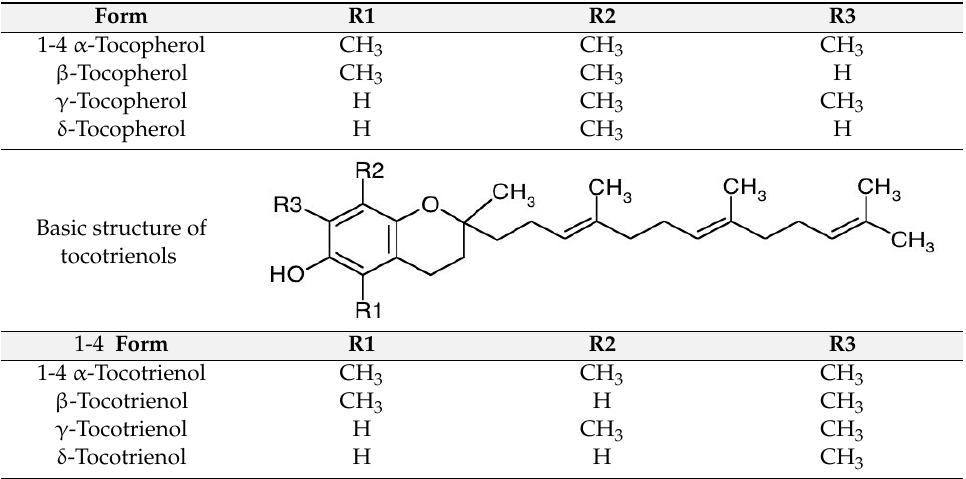
Table 1. Chemical structure of tocopherols and tocotrienols. Tocopherols have a saturated phytyl tail. Form